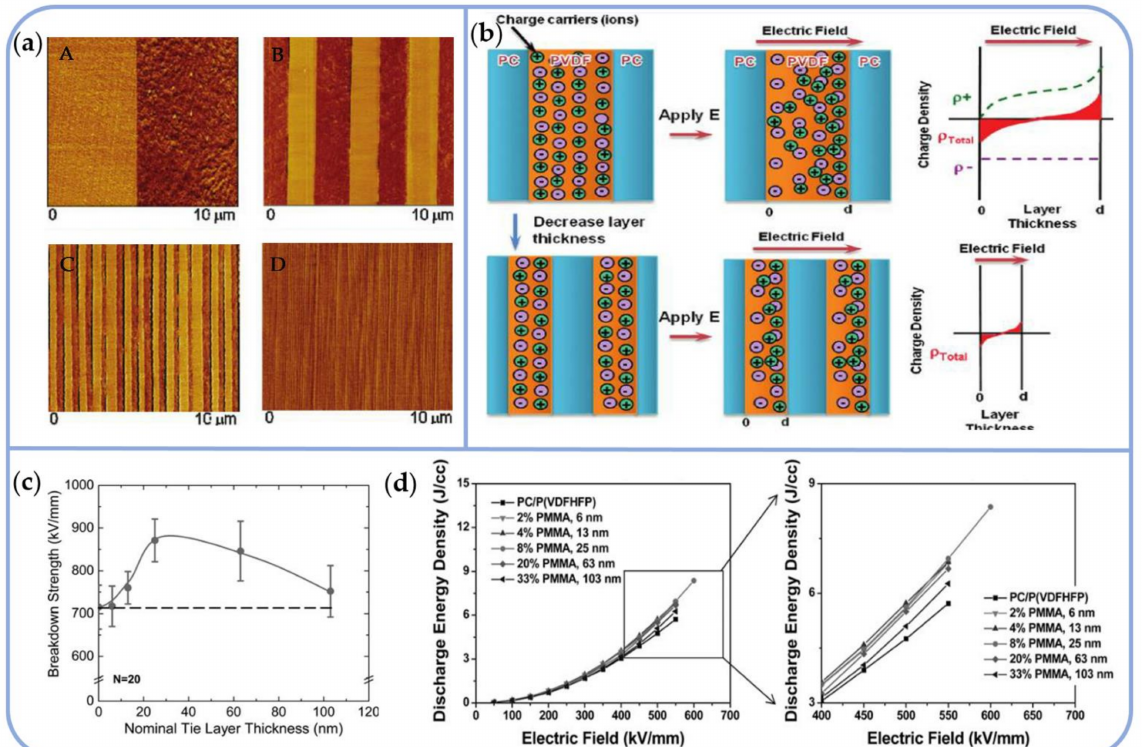
Figure 15. ( a ) The 2-A, 8-B, 32-C, and 256-D layer 50PC/50PVDF AFM phase images; ( b ) Schematic diagram of charge transfer. Reprinted with permission from [141]. Copyright (2012), American Chemical Society. ( c ) The breakdown strength of 33-layer PC/P(VDF-HFP), indicated as a dashed line, and the dielectric breakdown strength was evaluated for the 65-layer PC/PMMA/P(VDF-HFP) system as a function of PMMA layer thickness. ( d ) Discharge energy density comparison curves of the 65-layer PC/ PMMA/P(VDF-HFP) film and the 33-layer PC/P(VDF-HFP) film. Reprinted with permission from [143]. Copyright (2013),